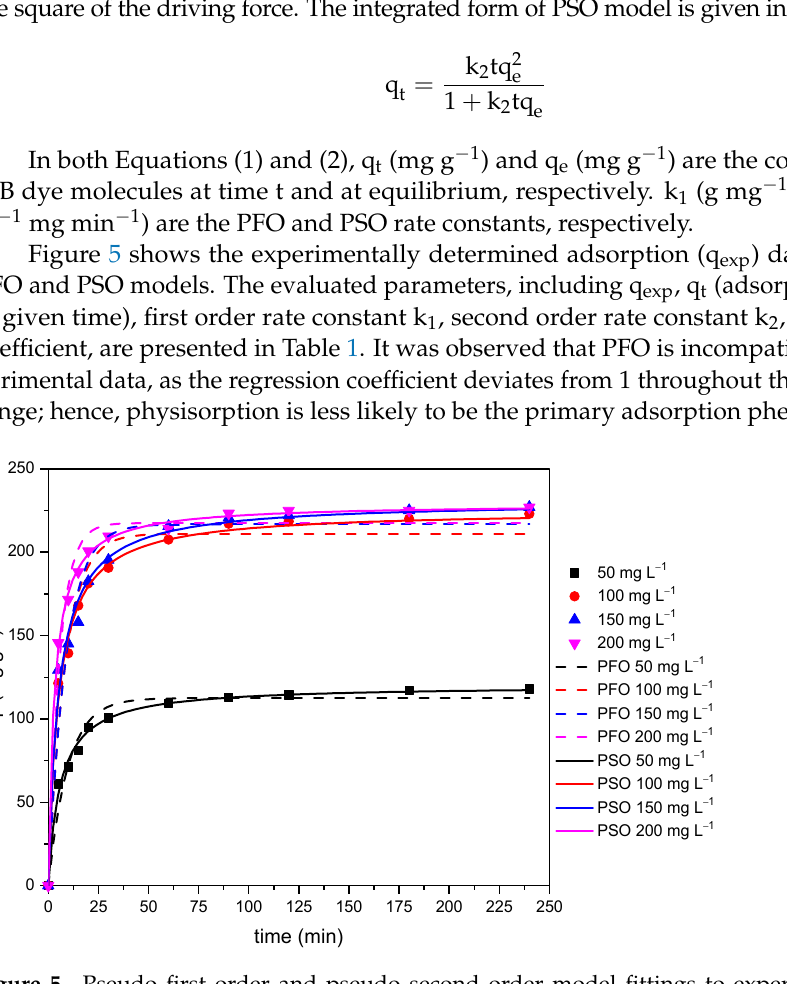
Figure 5. Pseudo first order and pseudo second order model fittings to experimental data for adsorption of MB on CXTi synthesised in this study, at initial concentrations of 50, 100, 150 and 200 mg L − 1 (T = 23 °C, dose = 0.01 g mL − 1 ). Table 1. Kinetic constants for MB adsorption by CXTi; q exp is the experimental amount adsorbed at